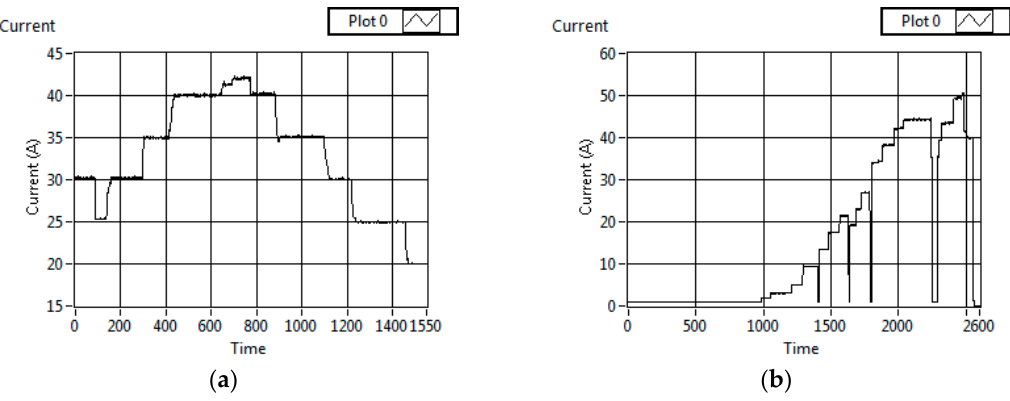
Figure 7. Current load profiles used in the validation. ( a ) Profile 1; ( b ) Profile 2.